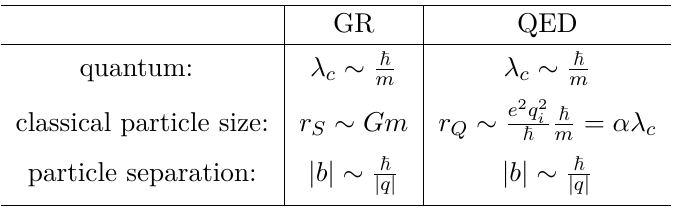
Table 1 . Comparison between relevant length scales in the post-Minkowskian (PM) expansion in GR and the post-Lorentzian (PL) regime in (scalar) QED in units where c = 1 and the fundamental charge e is measured in units where (cid:15) 0 = 1 . The classical impact parameter b is Fourier conjugate to the momentum transfer q/ ~ in scattering